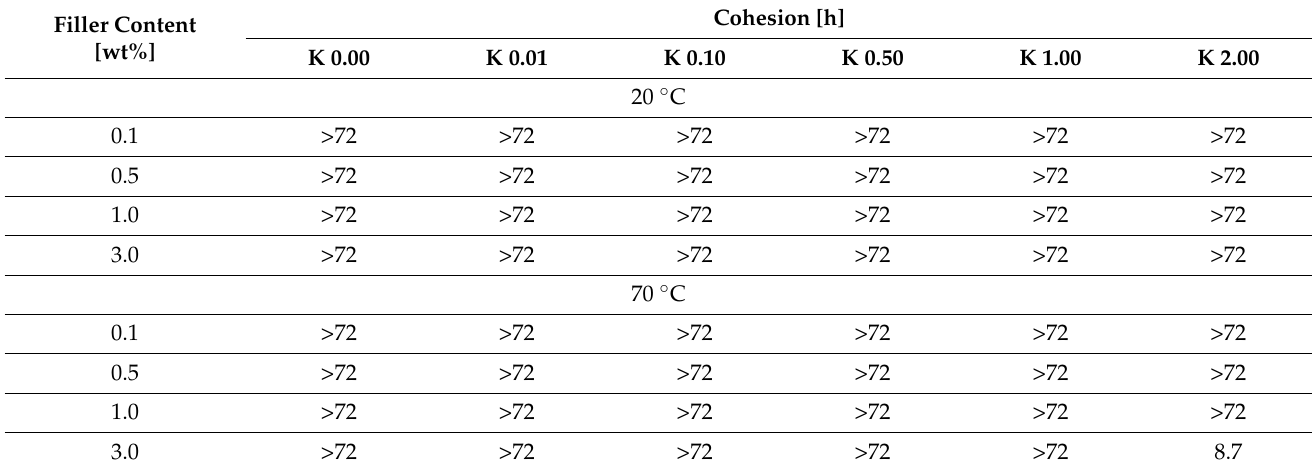
Table 6. Cohesion at 20 and 70 ◦ C of Q2-7355 resin-based adhesives with clinoptilolite.